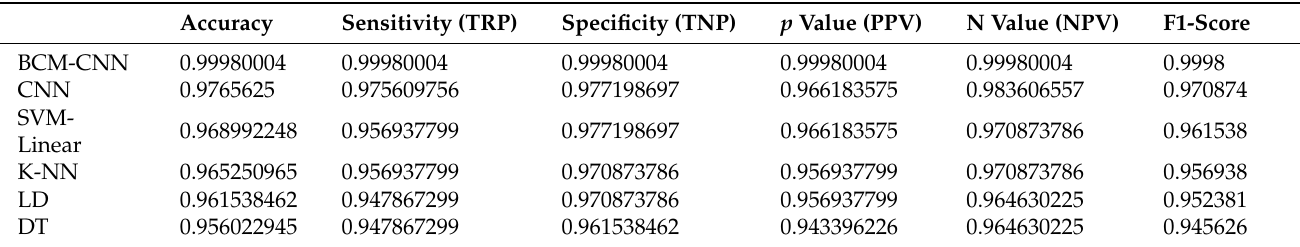
Table 6. The performance of the proposed method (BCM-CNN) versus basic